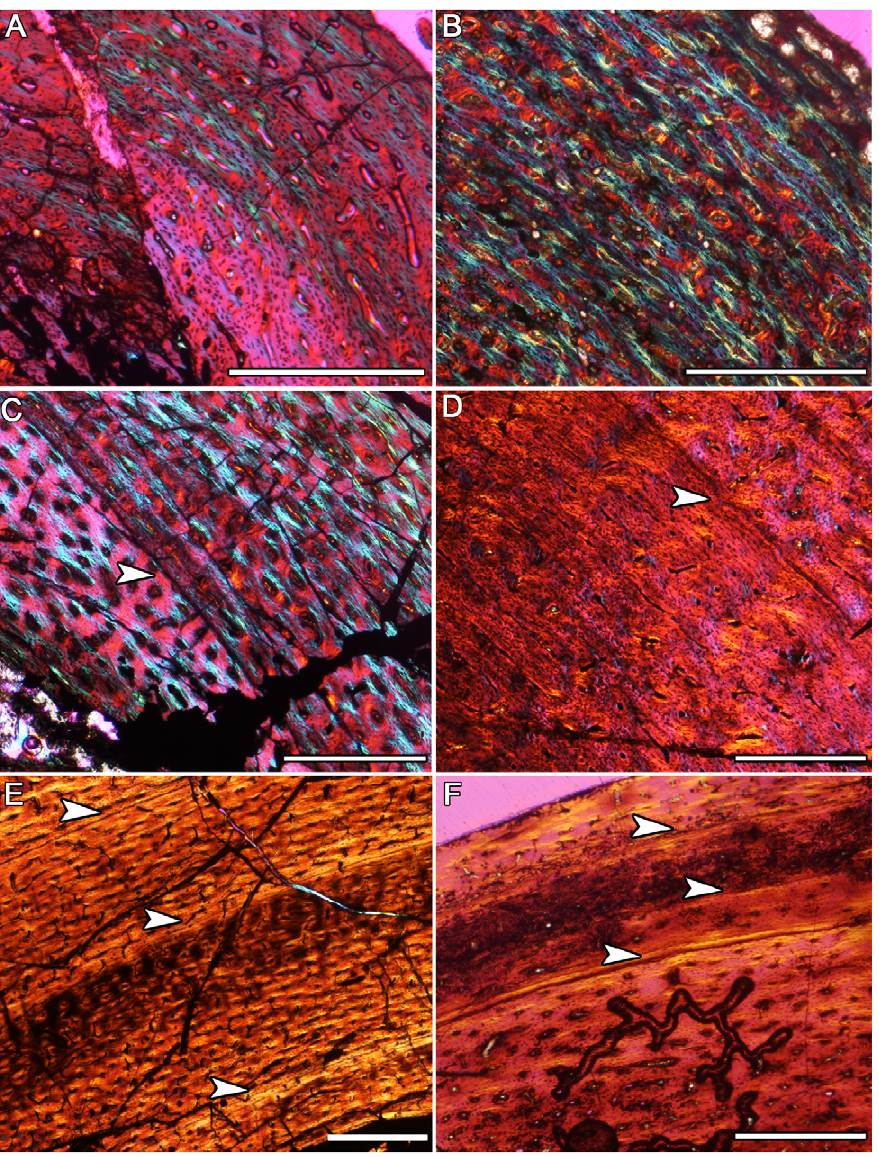
Figure 1. Hypsilophodontid ontogenetic bone microstructure. The bone microstructures observed in hypsilophodontids from Victoria (left column) suggest ontogenetic status, and strongly resemble microstructures observed in hypsilophodontids from lower latitudes (right column; Museum of the Rockies- MOR; Brigham Young University- BYU). Arrows indicate LAGs. Scale bars, 500 m m. A) Femur (NMV 216768) diaphyseal section from a skeletally immature polar hypsilophodontid. Growth marks are absent and tissue consists of rapidly deposited, disorganized woven fibers. This resembles the femoral diaphyseal section in B), from an Orodromeus (MOR 407). C) Diaphyseal section of a femur (NMV 208495) showing one LAG within fast growing woven tissue. LAGs within woven tissue are also observed in D), a femur from a Dryosaurus (BYU 13312). E) Diaphyseal section of a tibia (NMV 228434) consisting of three well-defined LAGs within loosely parallel-fibered cortex, representing a slowly growing individual approaching skeletal maturity. A similar microstructural pattern is observed in F), an Orodromeus tibia (MOR 973) possessing LAGs within a parallel- fibered matrix.